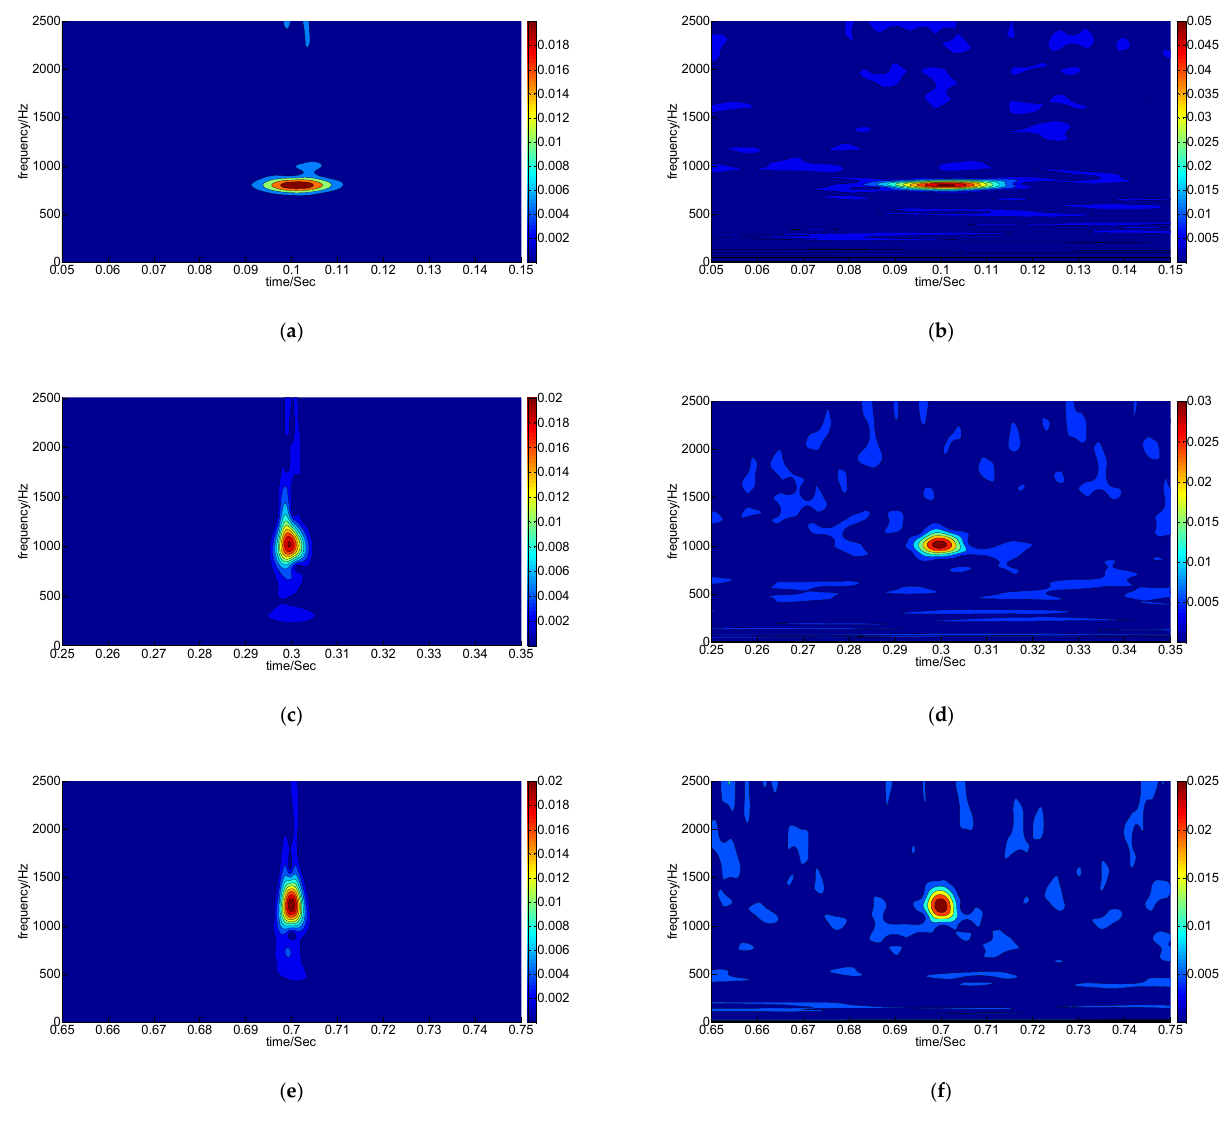
Figure 7. Comparison of proposed method and traditional method: ( a ) first impulse, proposed √ method, λ = 3 ∗ 0.197, u = 0.1002, f = 800, ϕ = 0.07 π ; ( b ) first impulse, tradi- tional method, λ = 0.213, u = 0.1002, f = 801, ϕ = − 0.08 π ; ( c ) second impulse, proposed √ method, λ = 3 ∗ 0.404, u = 0.2998, f = 1002, ϕ = − 0.11 π ; ( d ) second impulse, tradi- tional method, λ = 0.388, u = 0.2996, f = 1007, ϕ = 0.17 π ; ( e ) third impulse, proposed method, √ λ = 3 ∗ 0.506, u = 0.7000, f = 1207, ϕ = − 0.08 π ; ( f ) third impulse, traditional method, λ = 0.476, u = 0.7000, f = 1213 ϕ = − 0.12 π . The decomposed results are shown in Figure 8. Table 3. Time–frequency factors of S 1 with the proposed